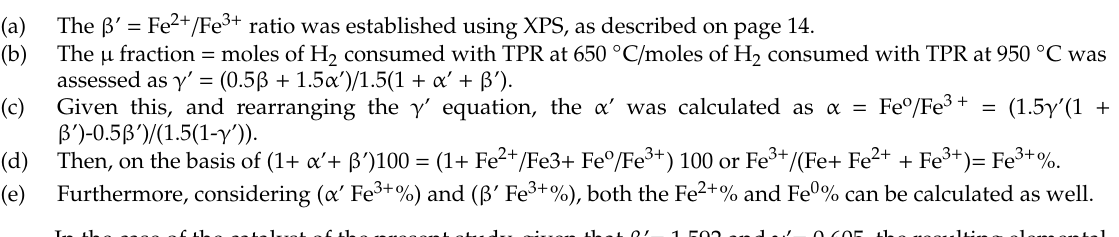
Figure A5. Coke deposition after 30 s of reaction time, at 500 °C in the CREC riser simulator: ( a ) γ-Al 2 O 3 , ( b ) 10% CaO- γ-Al 2 O 3. Note: model compound: 2M4MP, S/B =